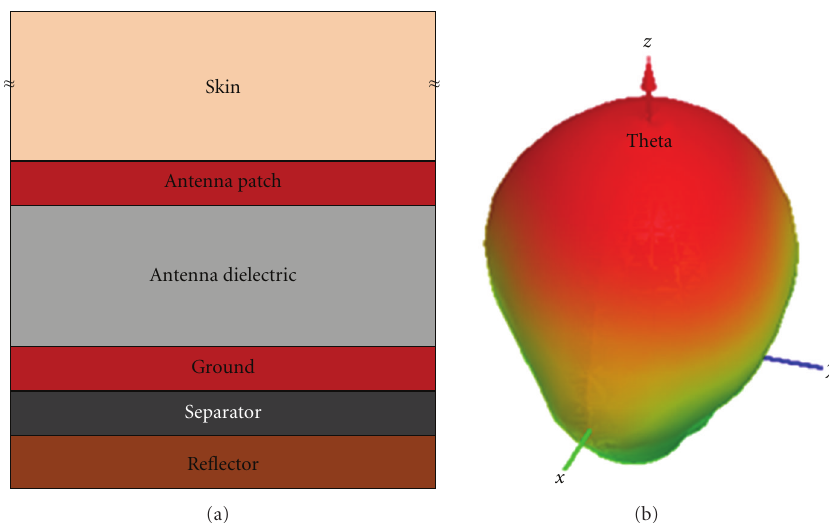
Figure 5: (a) Schematic showing the added reflector layer at the back of the ground and (b) 3D radiation pattern of the antenna with the reflector configuration.